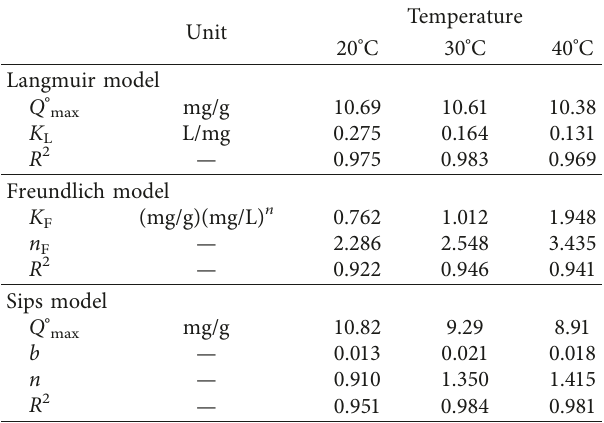
Table 1: The calculated isotherm parameters of Langmuir, Freundlich, and Sips models for Cr(VI) adsorption on FSS at various